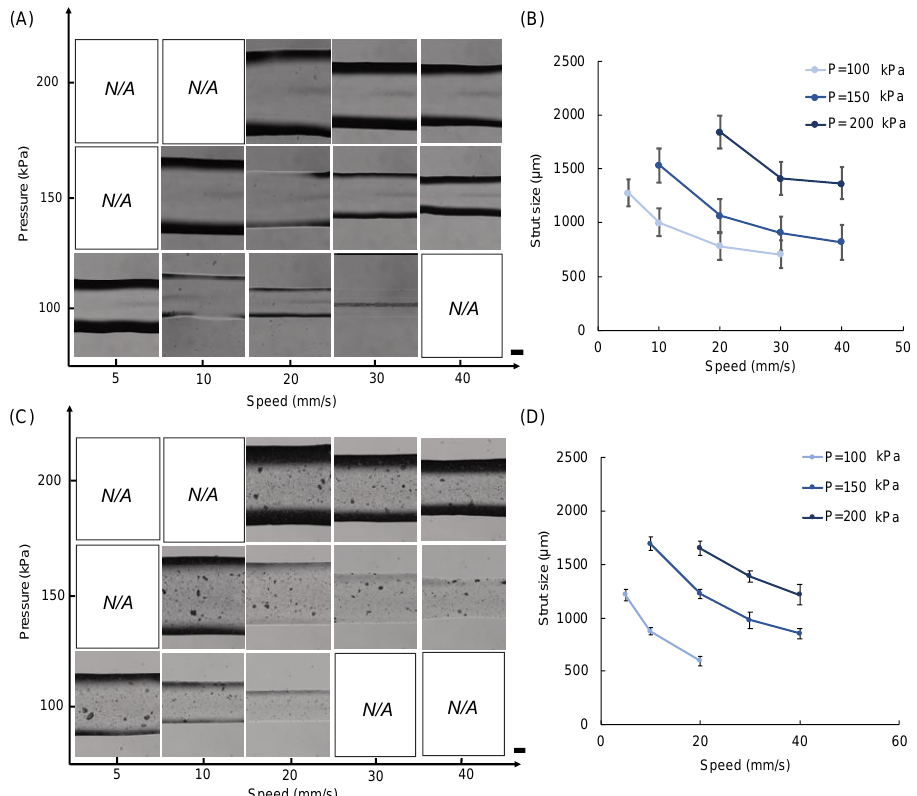
Figure 6. Standard line test results for ( A , B ) neat ( N ) and ( C , D ) composite ( C ) inks. Microscope images showing the 3D printed lines (struts) ( A , C ) and plots showing the corresponding measured strut width values ( B , D ). Scale bars are 200 microns. Data are presented as mean ± std. deviation for n = 3 samples with 3 measurements for each sample.